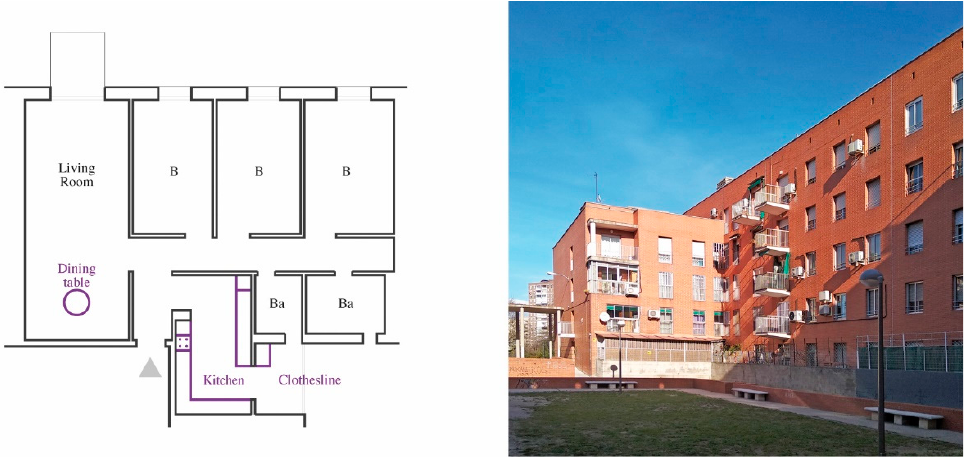
Figure 13. Palomeras housing, UV 9 Plot. Three-bedroom apartment. Plan redrawn and photo by author.